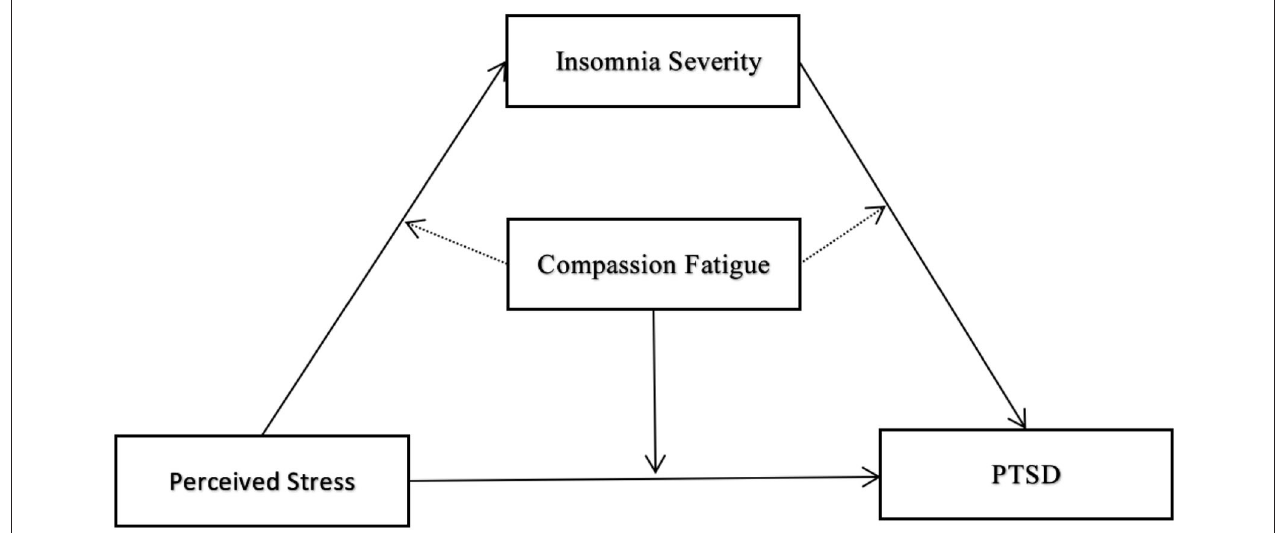
FIGURE 1 | The conceptional framework of the moderated mediation model.